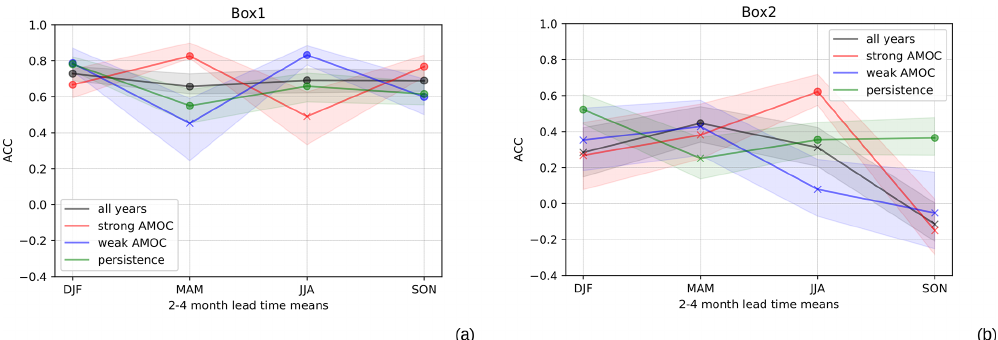
Figure 9. SST ACCs against ERA-Interim at a 2–4-month lead time averaged over the regions shown in Fig. 4a. (a) Box 1 (10.5–22.5 ◦ N, 22–55 ◦ W) and (b) Box 2 (28.5–40.5 ◦ N, 40–70 ◦ W). Black lines represent the ACCs considering the full time series (1982–2014), red lines the strong and blue lines the weak AMOC phases. A baseline persistence forecast can be seen in green. The shaded areas indicate the interquartile ranges, and markers indicate significance at the 95% level (circles for significant and crosses for insignificant correlations).